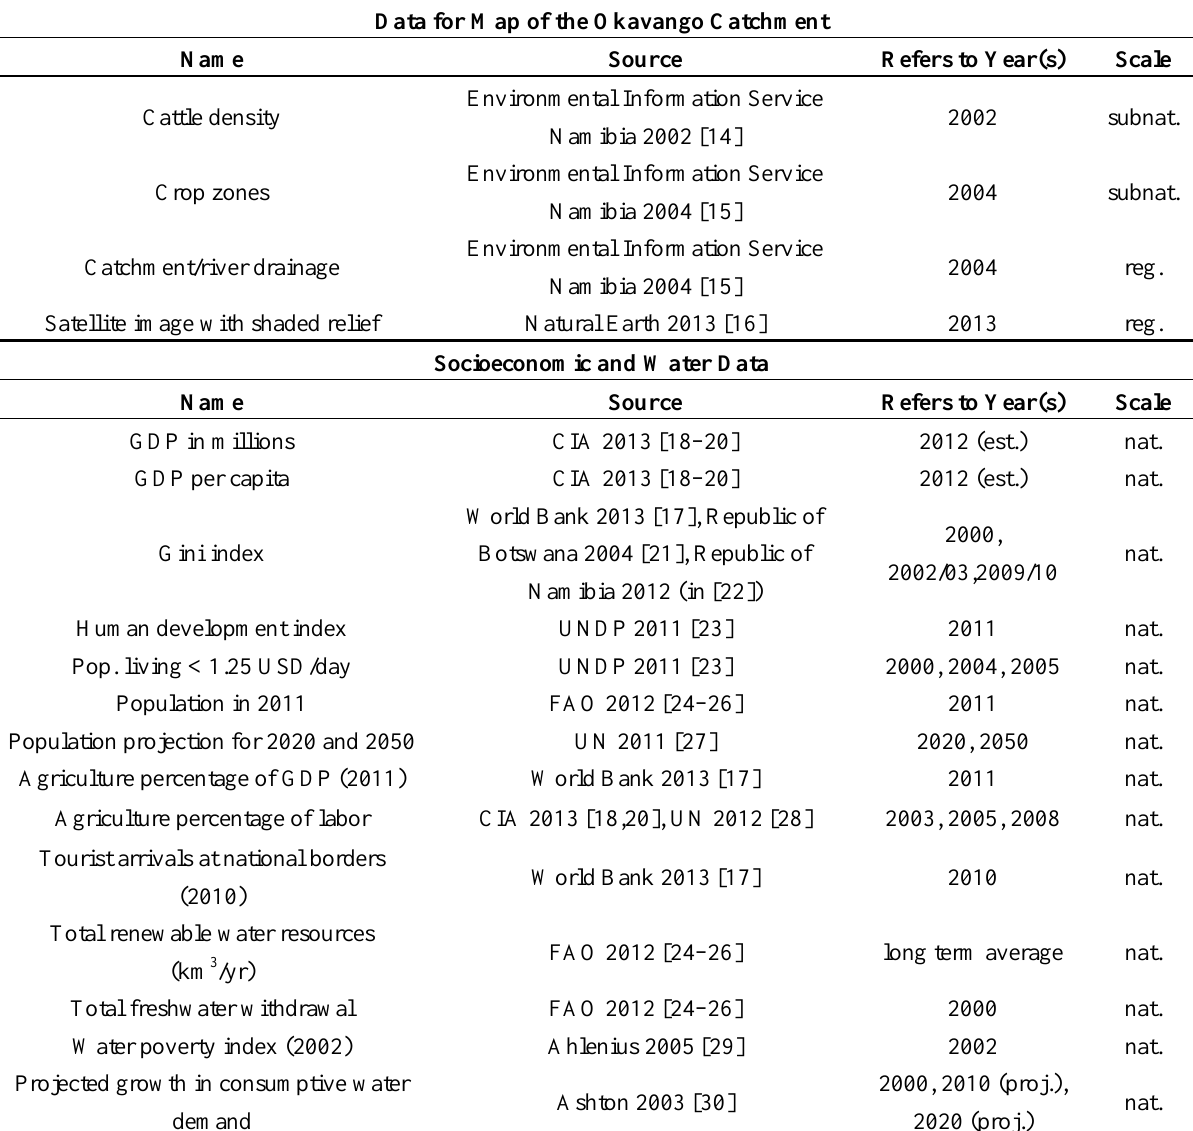
Table 1. Overview of used data (in order of occurrence in the